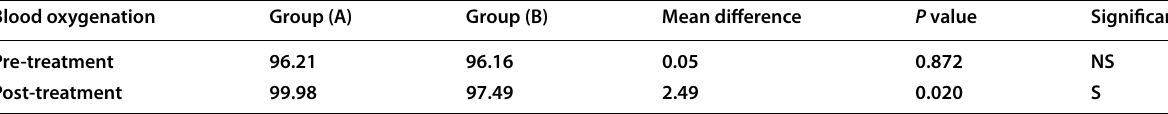
P probability, S significance, NS non-significant